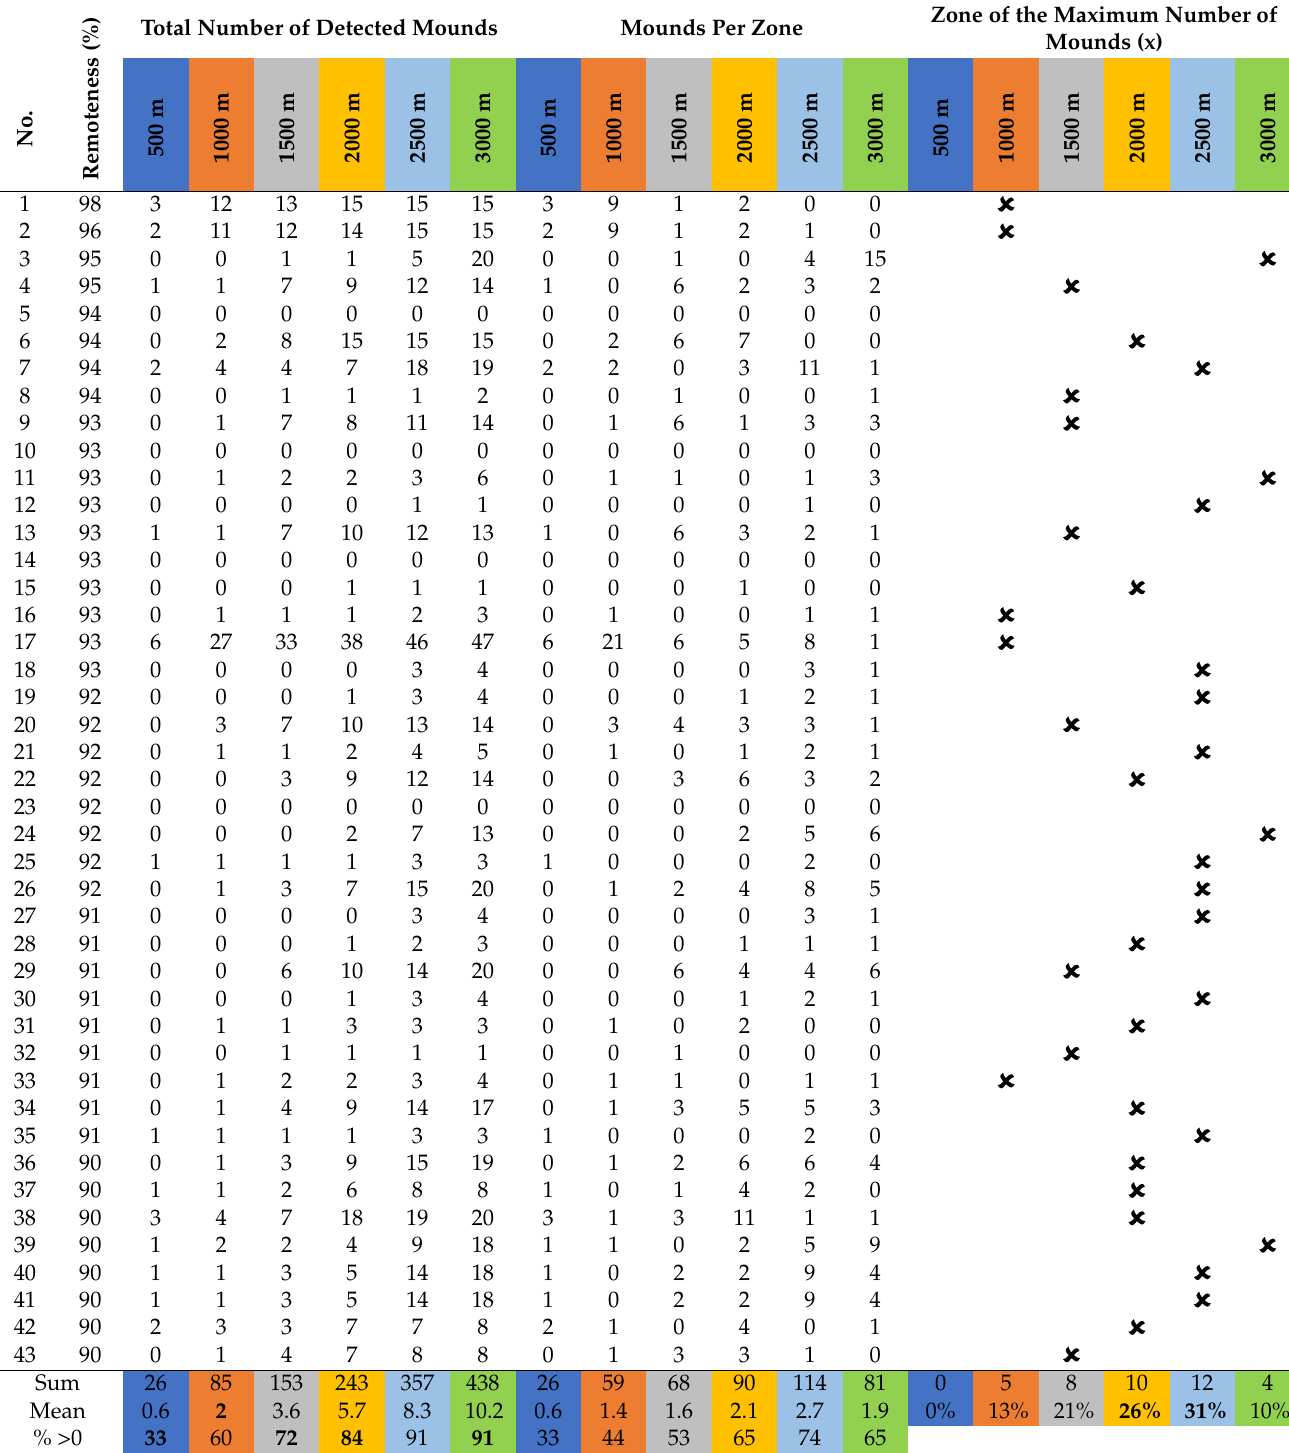
Table 1. Detailed list of all results. Numbers that are referenced in the text are